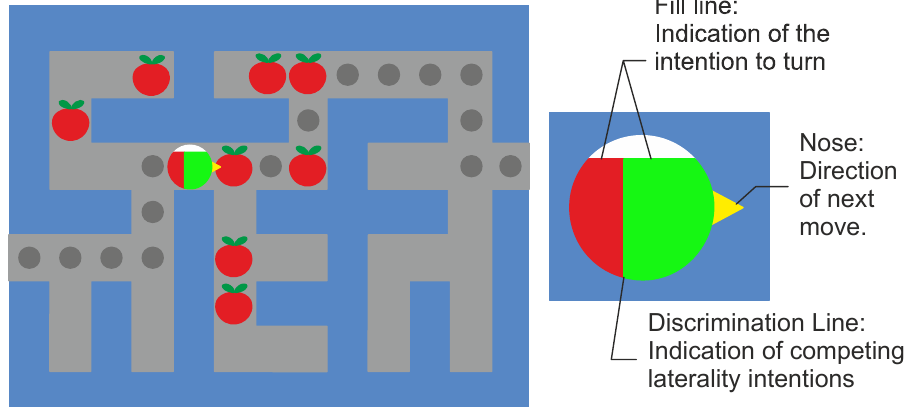
Figure 10. Pacman game. The gamer has to move through the maze to reach the exit in the right wall. The shortest path is marked with gray track marks, but the gamer can decide to run the rest of maze to receive additional credits (adapted from [296]).